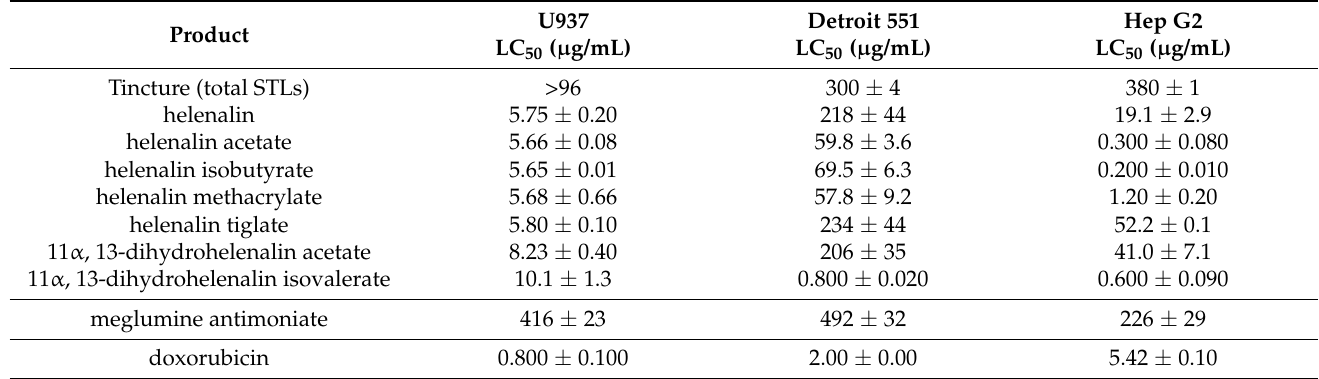
Table 1. Cytotoxic activity of Arnica tincture and isolated STLs. Data represent the mean lethal concentration (LC 50 ) in µ g/mL for each substance ± SD ( n = 3 assays with 3 replicates in each case).